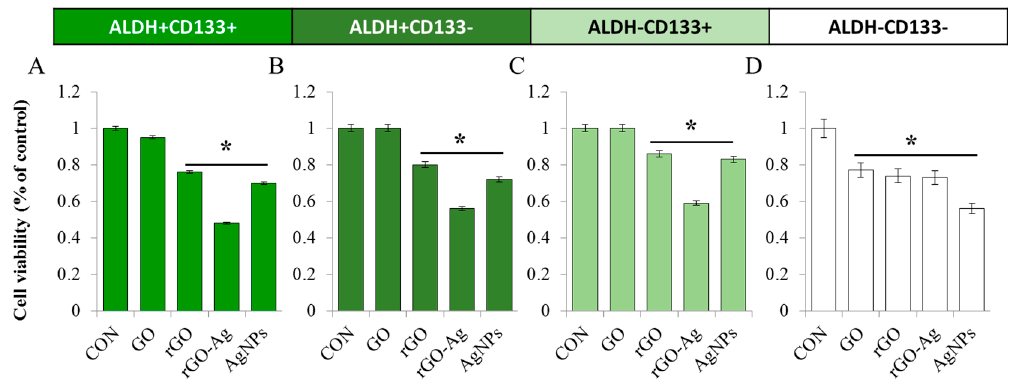
Figure 4. Effects of GO, rGO, rGO–Ag, and AgNPs on cell viability of various subpopulations of OvCSCs. The viability of ALDH + CD133 + ( A ), ALDH − CD133 + ( B ), ALDH + CD133 − ( C ), and ALDH − CD133 − ( D ) cells was determined after 24-h exposure to GO (60 µg/mL), rGO (20 µg/mL), rGO–Ag (2 µg/mL), and AgNPs (20 µg/mL) using the CCK-8 assay. The results are expressed as the mean ± standard deviation of three independent experiments. The viability of treated cells compared to untreated cells was analyzed using Student’s t -test (* p < 0.05).